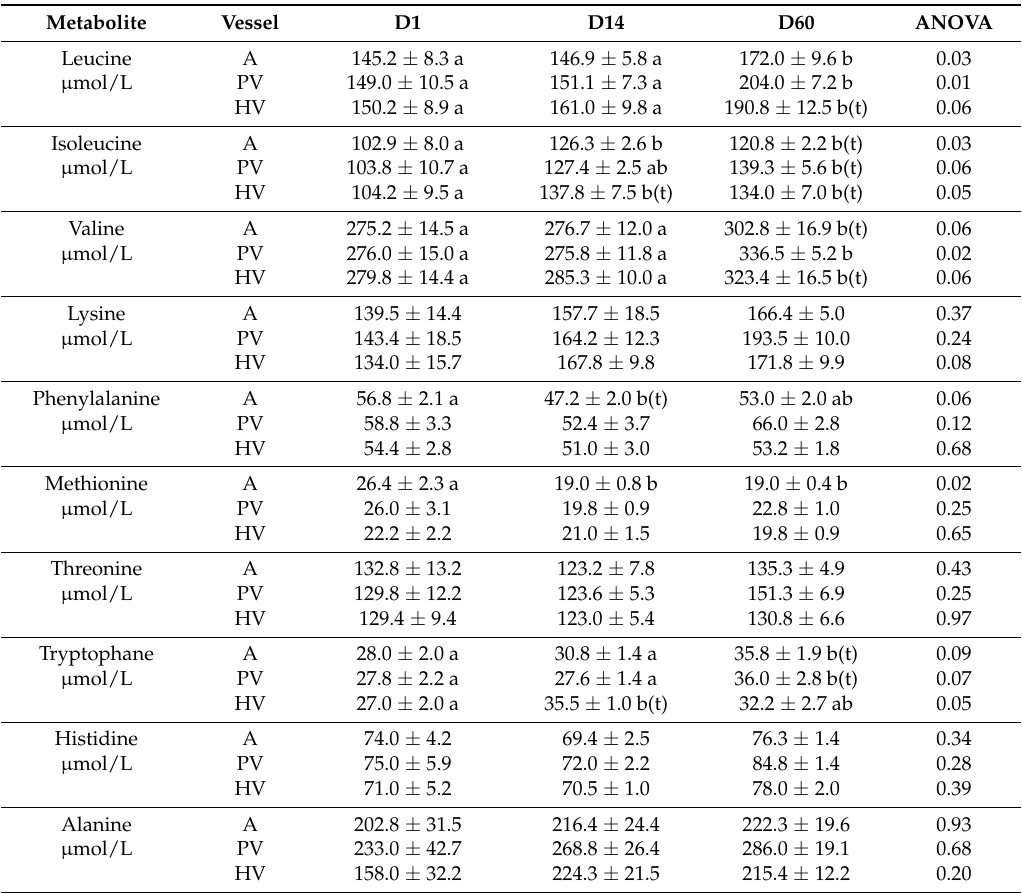
Table 3. Amino acids concentrations ( µ mol/L) in the fasted state in artery (A), portal vein (PV) and hepatic vein (HV) before (D1) and after 14 days (D14) and 60 days (D60) of adaptation to HFHS